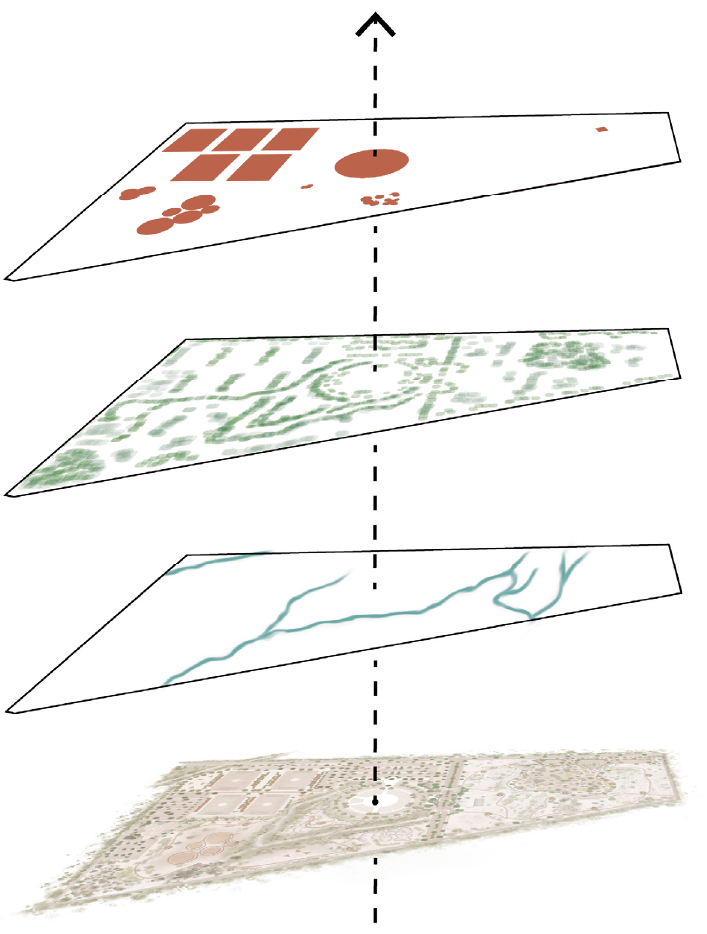
Figure 9. Data layers for the landscape design (from top to bottom—recreation areas, greenspace, riparian areas, and final master plan) (credit: I. Pineda).